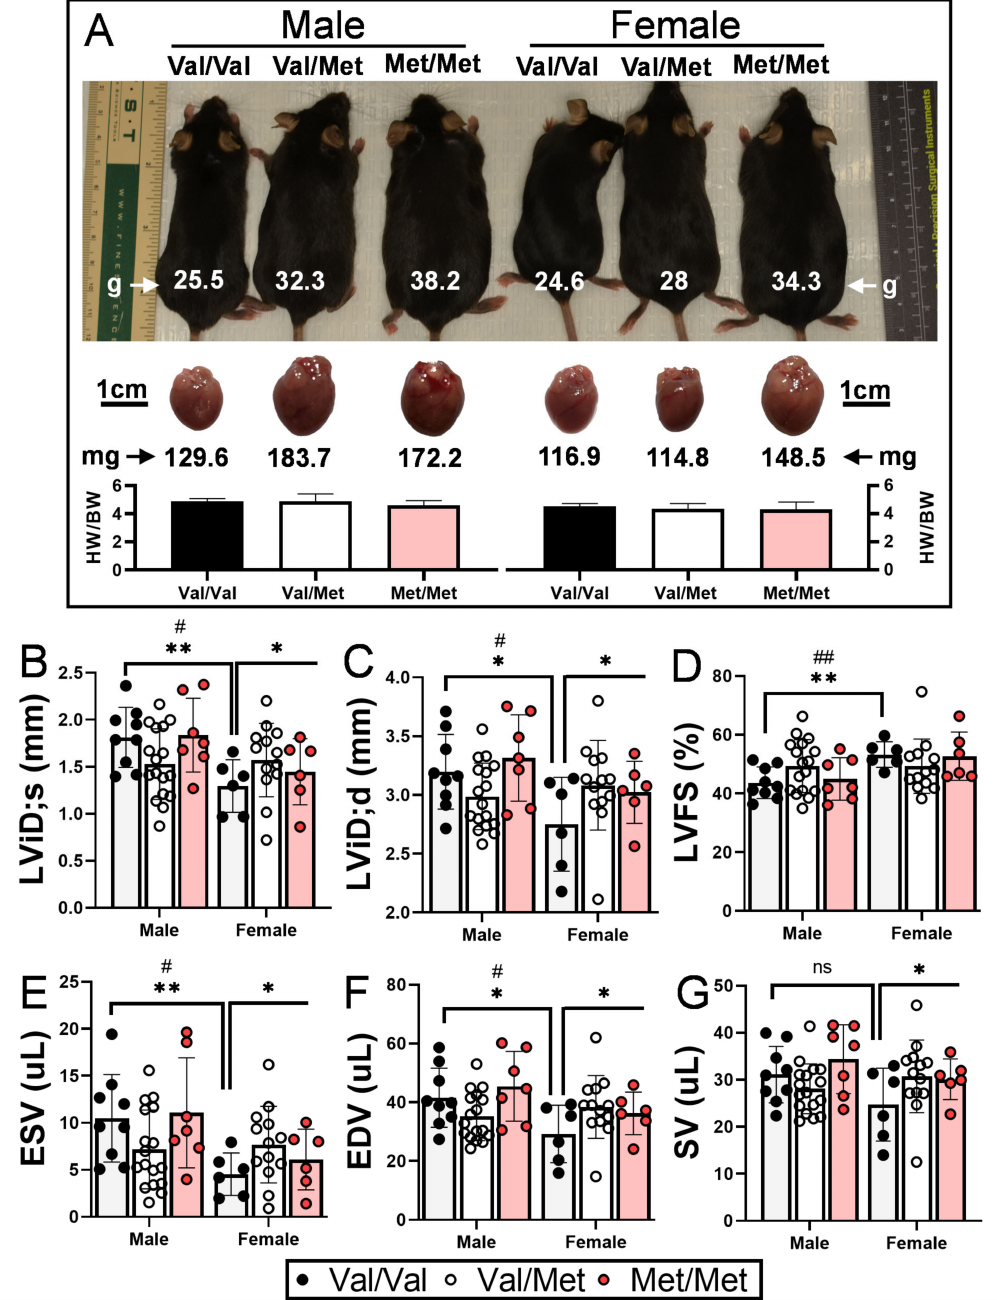
Figure 1. Val66Met leads to increased end systolic and diastolic volumes in female mice. ( A ) Representative 12-week-old littermate mice along with excised hearts from the same mice, showing greater body and heart weights in both males and females with the Met allele. Bars beneath representative hearts show similar heart weight-to-body weight ratios (HW/BW) among genotypes ( n = 4 per group). ( B – G ) Plot showing results of echocardiography assessment of littermate-matched male and female mice (8–12 weeks) with one (Val/Met, white bars and circles) or both (Met/Met, red bars and circles) of the rs6265 alleles, relative to non-carrier controls (light gray bars and black circles). Parameters shown ( y axis) are ( B ) left ventricular internal dimension at end systole (LVID;s) and ( C ) diastole (LVID;d), ( D ) percent (%), fractional shortening (FS), ( E ) end systolic volume (ESV), ( F ) end diastolic volume (EDV), and ( G ) stroke volume (SR). n = 9 (Male Val/Val), n = 17 (Male Val/Met), n = 7 (Male Met/Met), n = 6 (Female Val/Val), n = 13 (Female Val/Met), n = 6 (Female Met/Met). Asterisks represent statistical significance between male and female Val/Val mice or between Val/Val versus Val/Met and Met/Met female mice. * p < 0.05and ** p < 0.001 using two-way ANOVA. # p < 0.05 and ## p < 0.01 using Mann–Whitney, ns = not